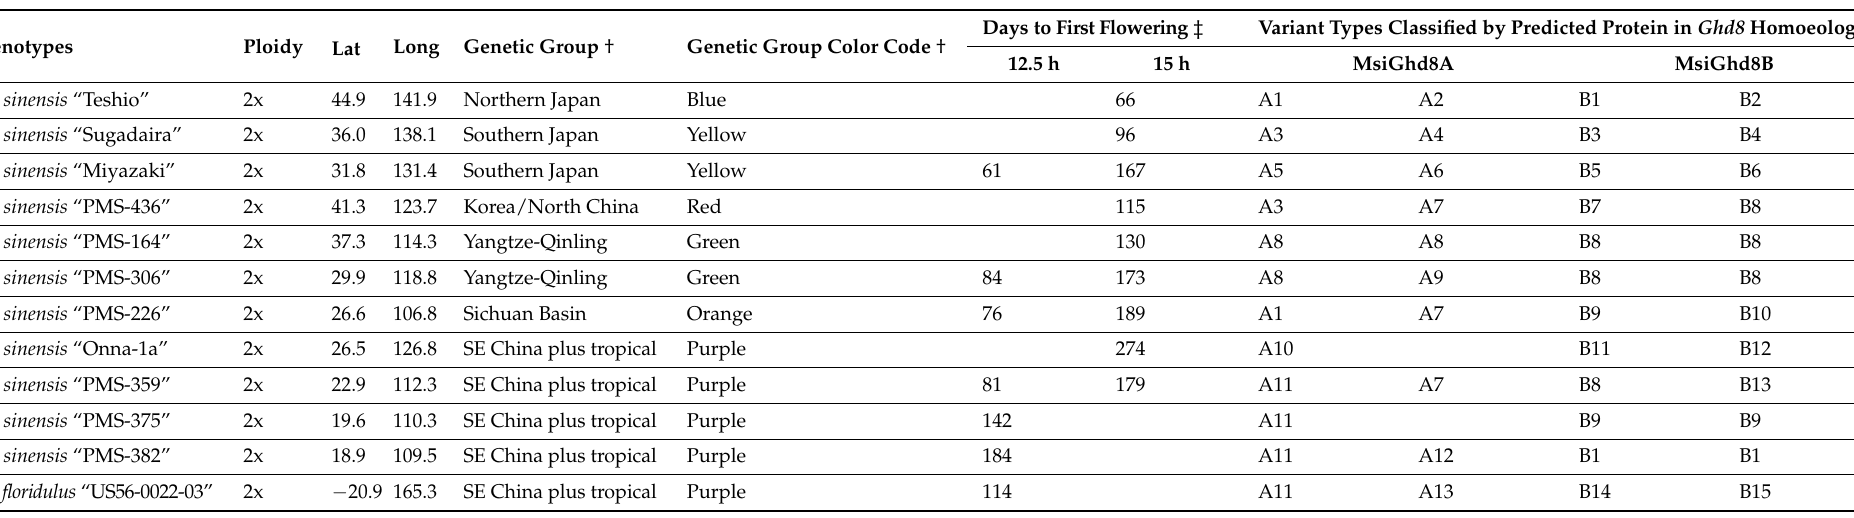
Table 1. Provenance, flowering time under short or long days and amino acid sequence diversity for two homoeologous Ghd8 loci in a mini-core panel of 11 Miscanthus sinensis and one Miscanthus floridulus